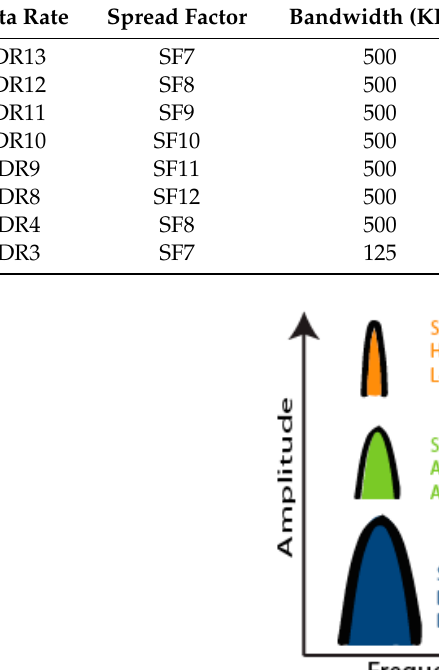
Table 6. LoRa parameters in US902-928 and AU915-928 bands, frequency of 915 MHz [56].